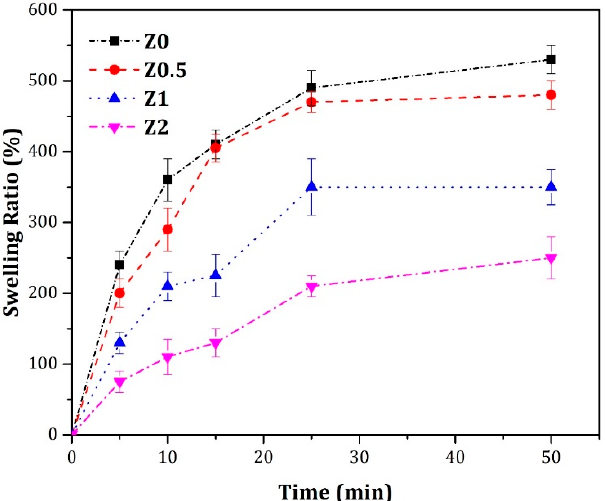
Figure 5. Swelling ratio of the hydrogel composite with different content of the